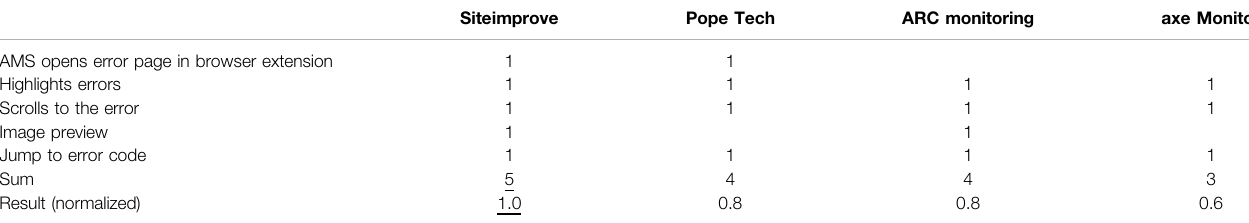
TABLE 4 | Support for localization of errors results.